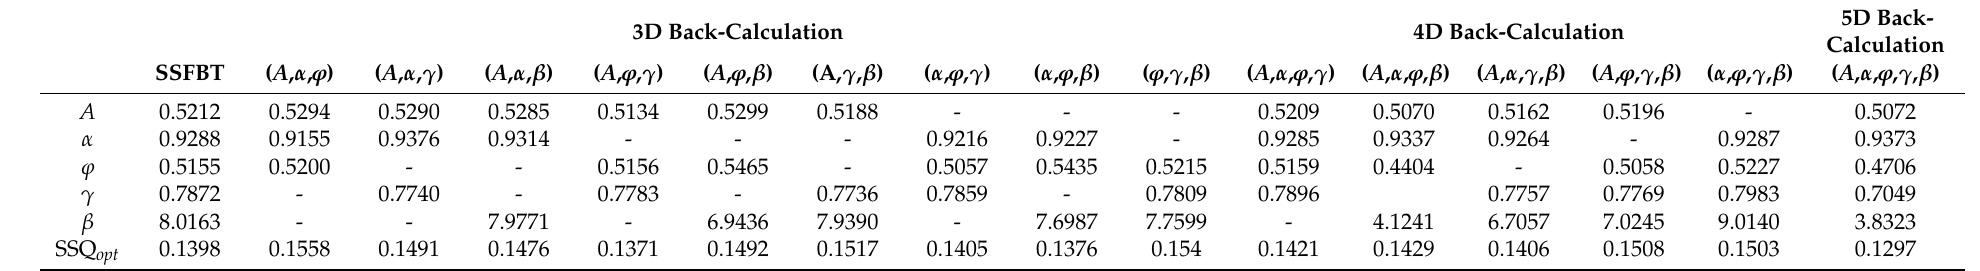
Table 4. Comparison between BFPs obtained from SSFBTs and back-calculated values in high-dimensional ( (cid:61) 3D) parameter spaces (molybdenum, dry). 3D